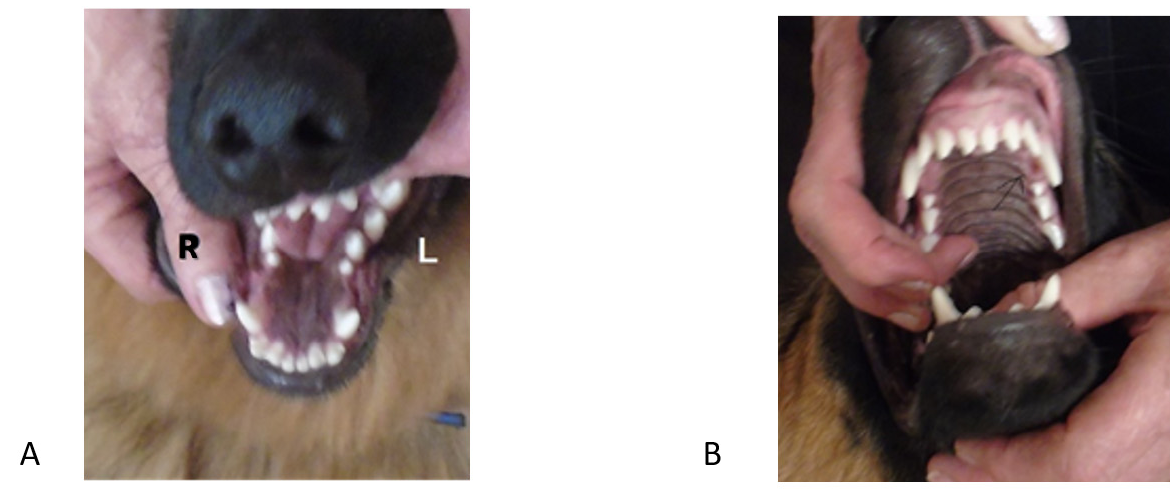
Figure 2. First case. Images in the occlusal projection. ( A ) mandibular arch, ( B ) maxillary arch—the arrow marks the recess. right (R) and left (L)